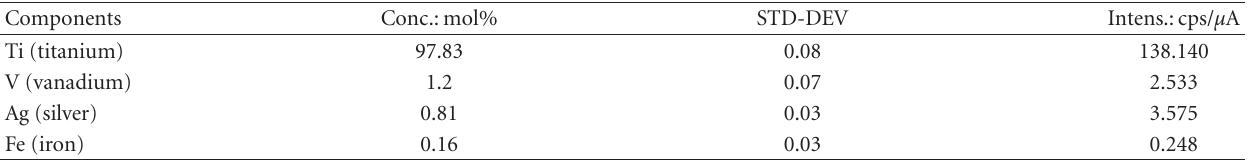
Table 1: XRF of prepared Ag-TiO 2 .